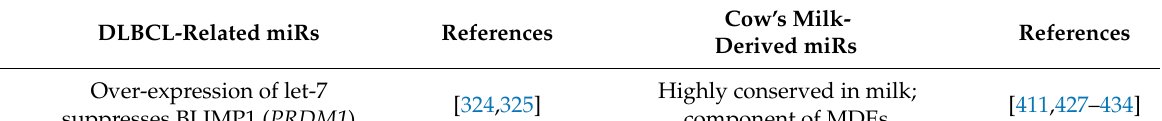
Table 3. Comparison of microRNAs (miRs) implicated in the pathogenesis of DLBCL with bioactive milk-derived